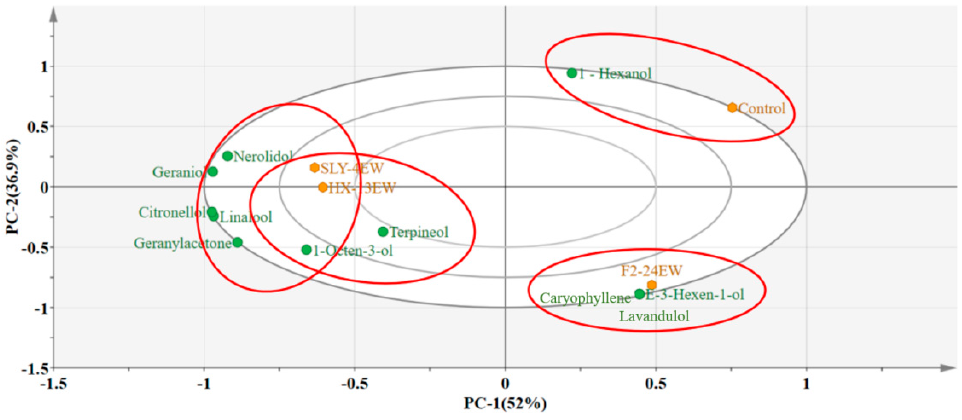
Figure 2. PCA of varietal aroma compounds and wines. Wines; Varietal aroma com- pounds.